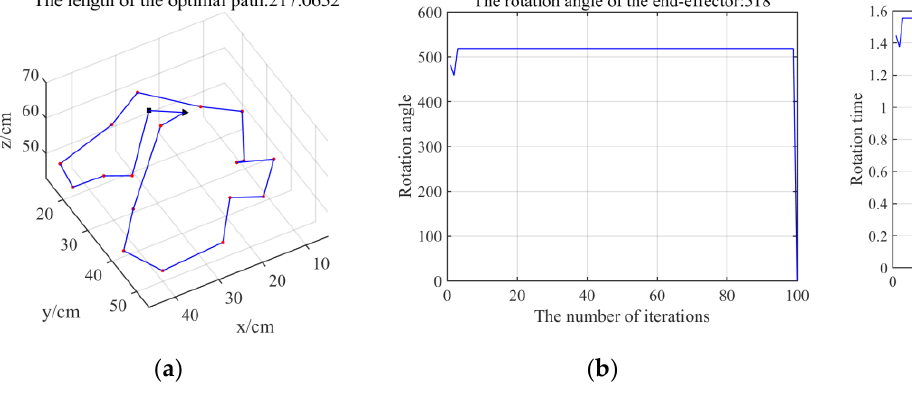
Figure 11. Simulation results of ACA with angle induction factor: ( a ) Path planning results; ( b ) Path length change curve; ( c ) Sum of the rotation time of shortest paths.